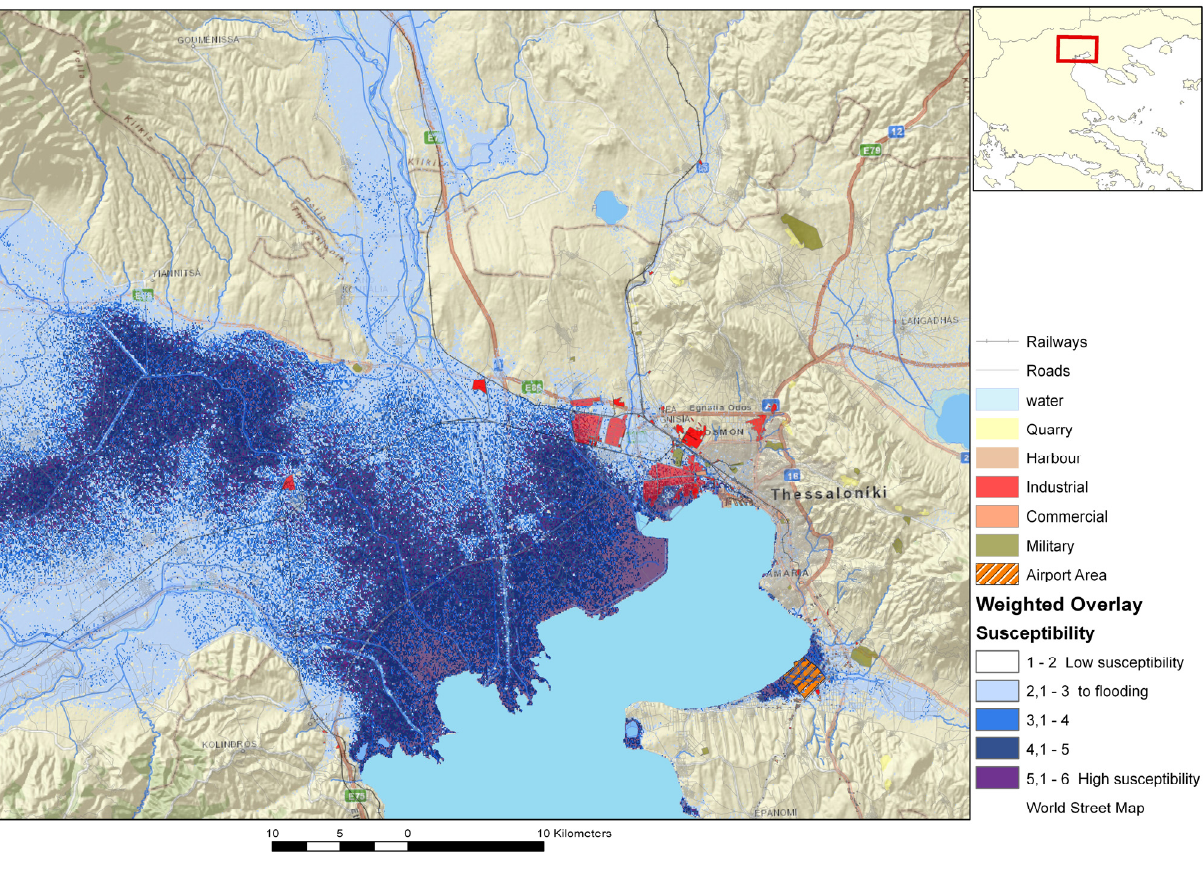
Figure 11. Susceptibility to flooding of the broader Gulf of Thessaloniki